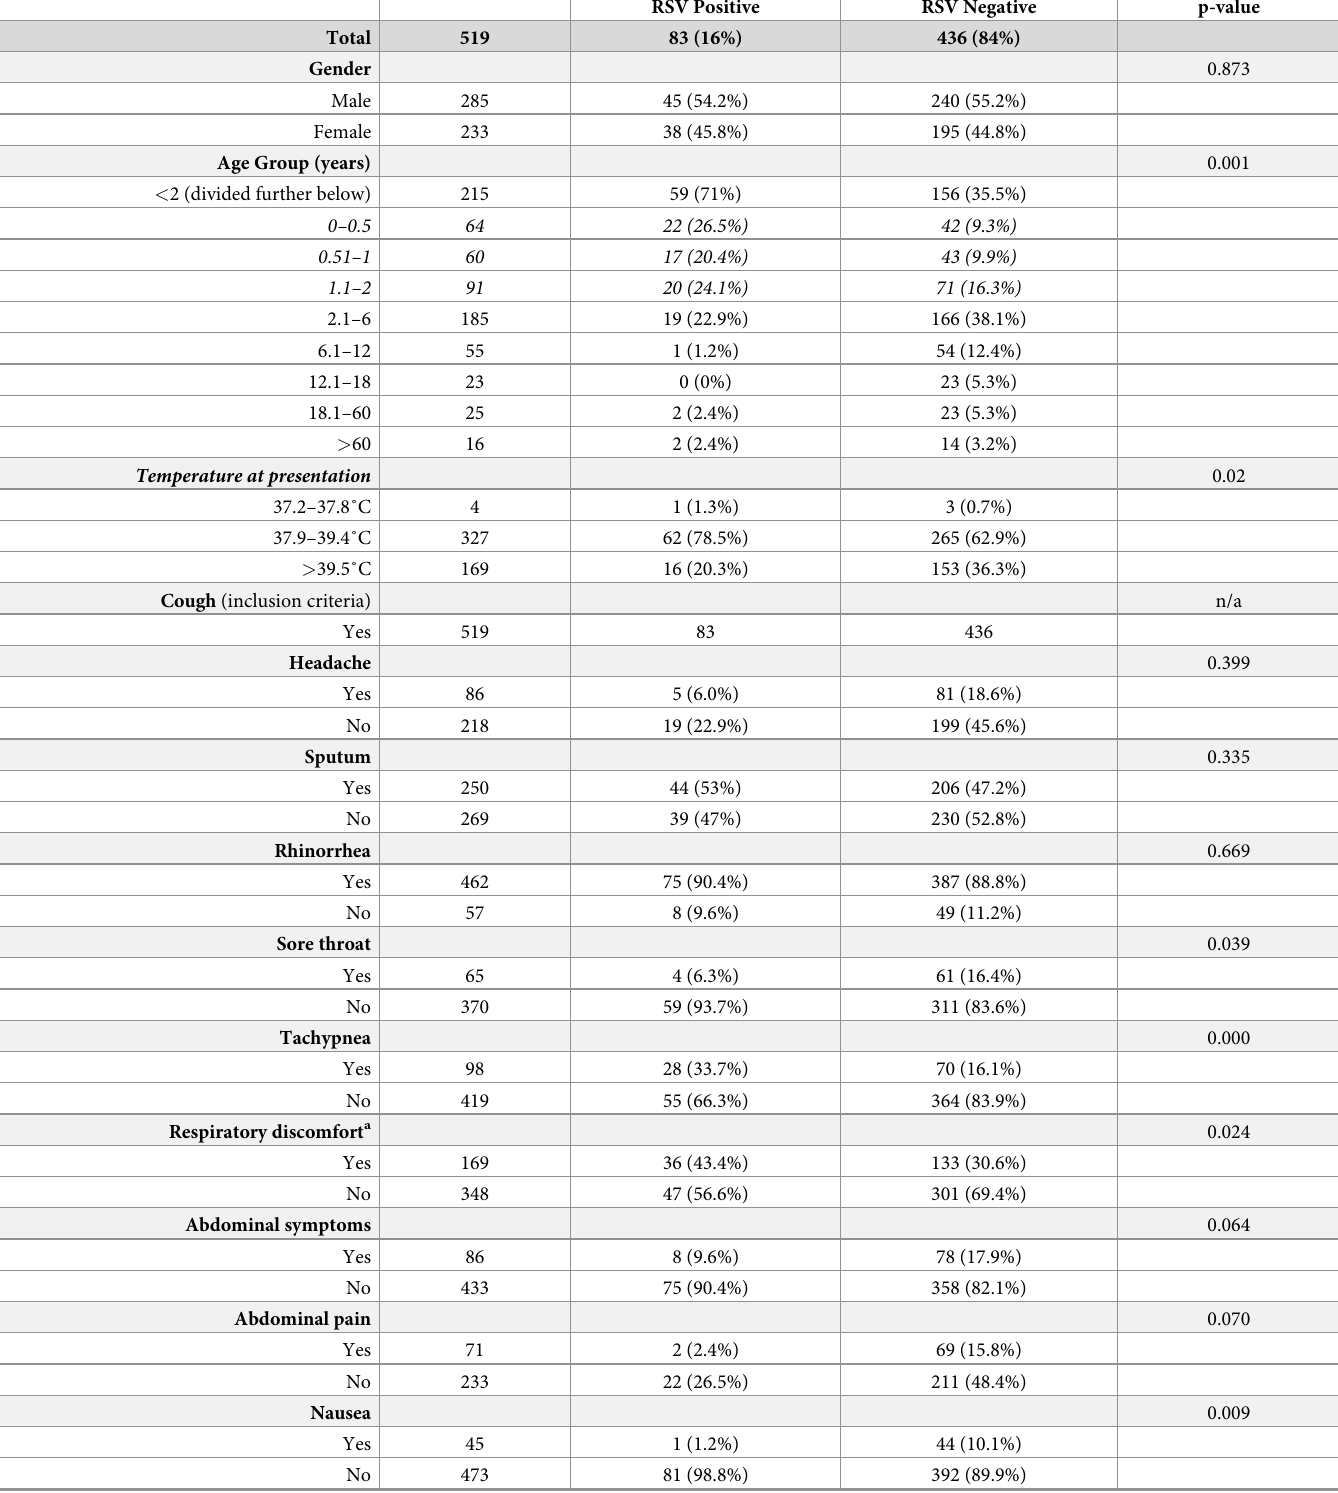
Table 1. Demographic and clinical characteristics of the 2016/17 season study